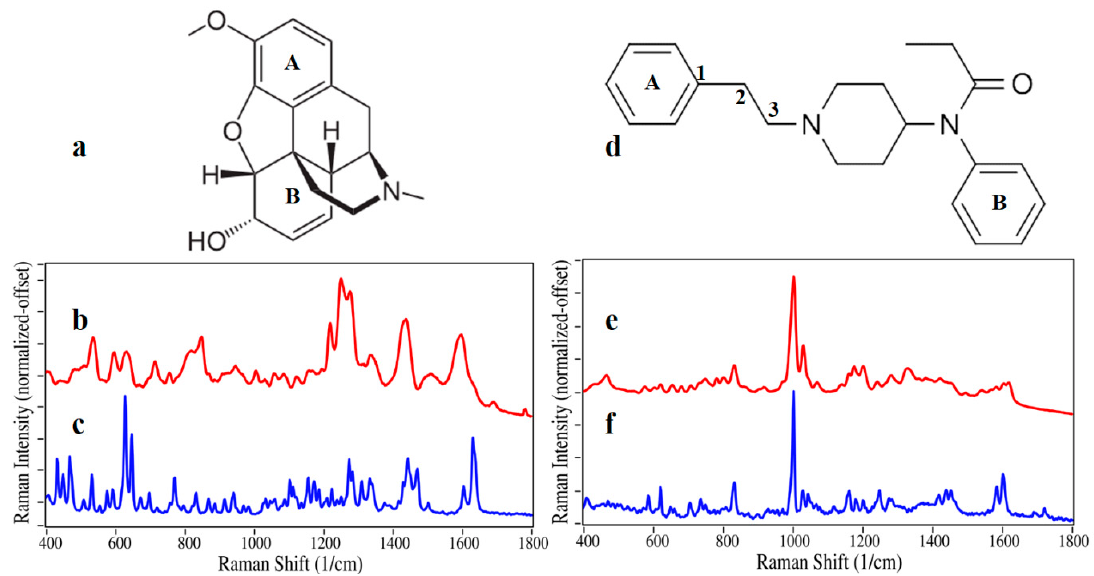
Figure 1. Codeine ( a ) chemical structure, ( b ) surface-enhanced Raman spectra (SERS), and ( c ) Raman spectra. Fentanyl ( d ) chemical structure, ( e ) SERS, and ( f ) Raman spectra. SERS conditions: 50 µg/mL, 40 mW at 785 nm, 3-sec scan per spectrum. Raman spectra are from Nicolet spectral library that used ~500 mW at 1064 nm.